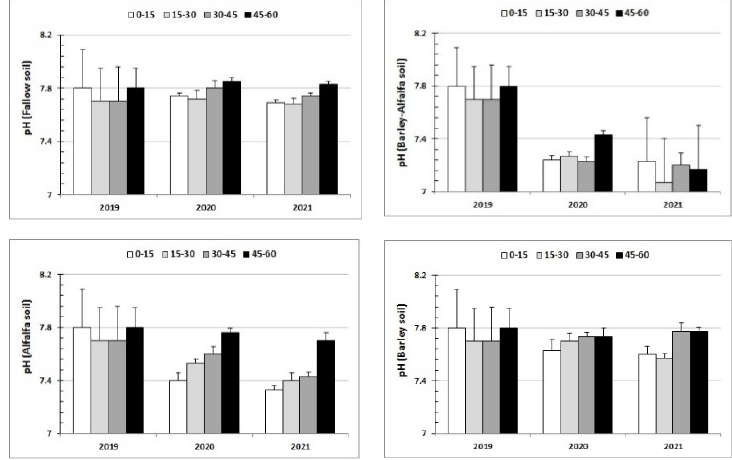
Figure 3. Variation of soil pH according to the vegetation in 2020 and